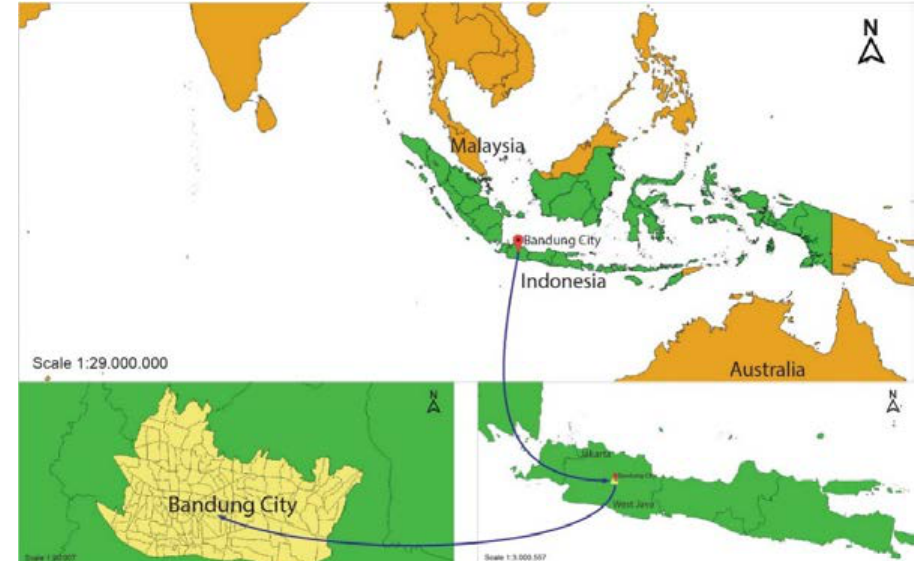
Fig. 1 : Geographic location of the study area in Bandung City, West Java,